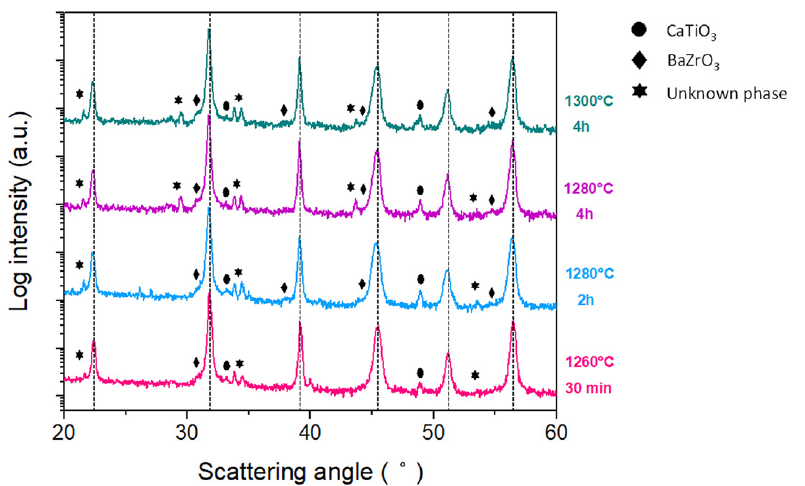
Figure 5. XRD diffraction patterns of the ceramics obtained by calcinating the powders at 700 ◦ C for 30 min and subsequent sintering of the pellets at different sintering times and temperatures, using a single sintering plateau. Vertical dotted lines indicate the main BCZT perovskite reflections. The secondary phases that accompany the main BCZT perovskite are